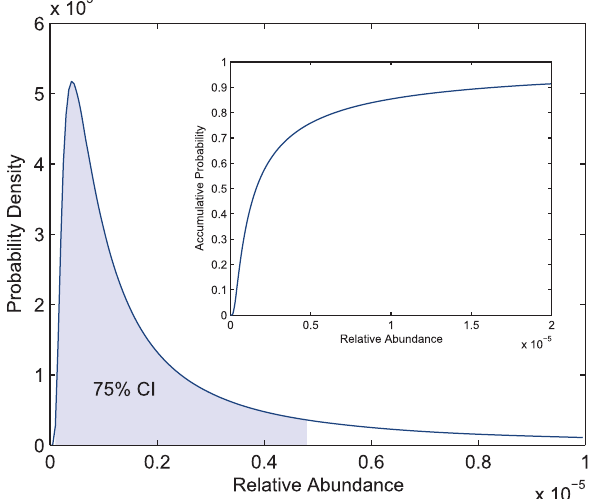
Figure 2. Monte Carlo simulation for the pooled library. Both axes are in logarithmic scale to make FOF data more legible. A virtual transcriptome is generated with S =77,152 according to the fitted RAD. With the same sample size as the pooled library, the simulated FOF data is plotted against the experimental observation. The simulation based on the fitted RAD and estimated transcriptome diversity S exactly replicates the SAGE experiment.